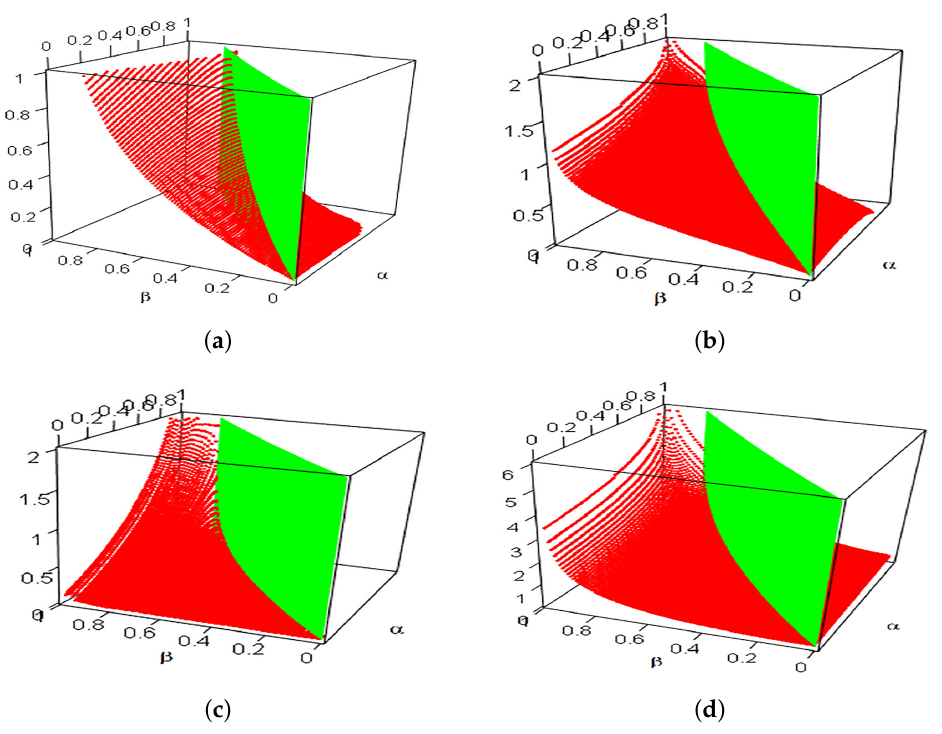
Figure 3. Difference surfaces (red) and β = [ α − C θ ( α , α )] / ( 1 − α ) (green). ( a